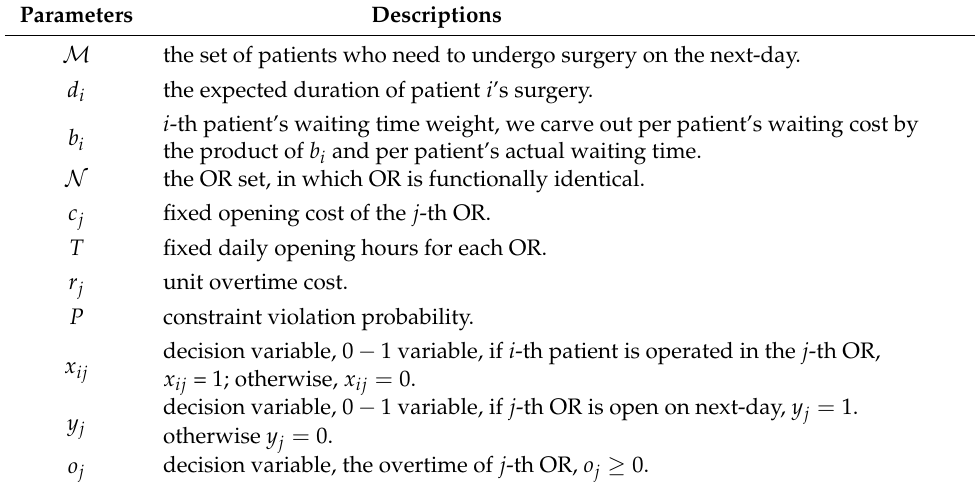
Table 1. Symbols and notations used in this